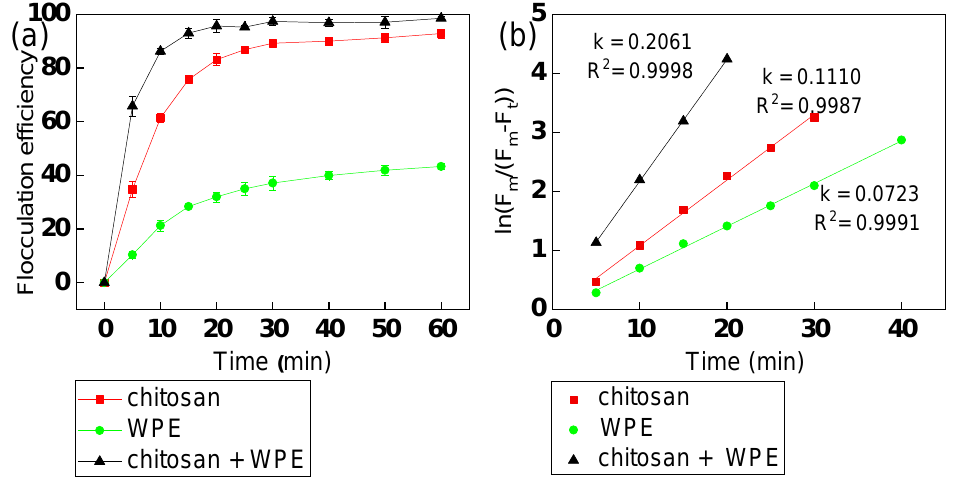
Figure 3. ( a ) The kinetics of C. vulgaris flocculation with various flocculants. ( b ) Flocculation kinetic curves of C. vulgaris flocculation with various flocculants. The error bars represent the standard deviation of the mean ( n = 3).